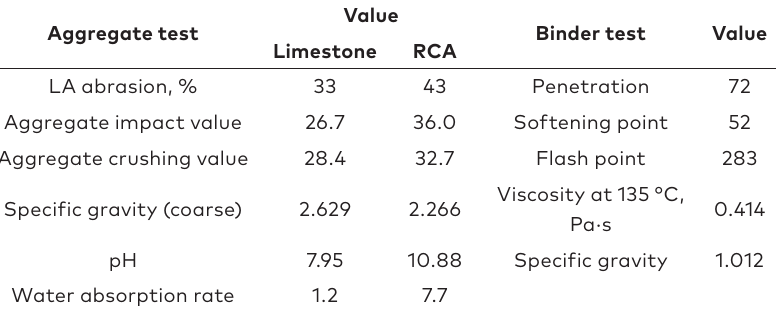
Table 1. Physical properties of aggregates and